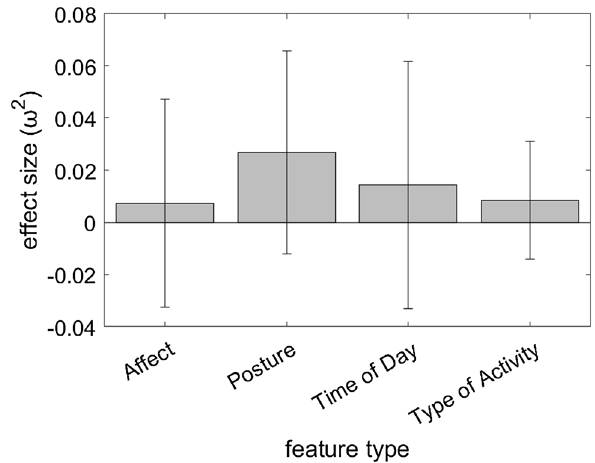
Figure 1. Comparison of effect size ( ω 2 ) by feature type in participant-level comparisons across clusters. Error bars represent standard